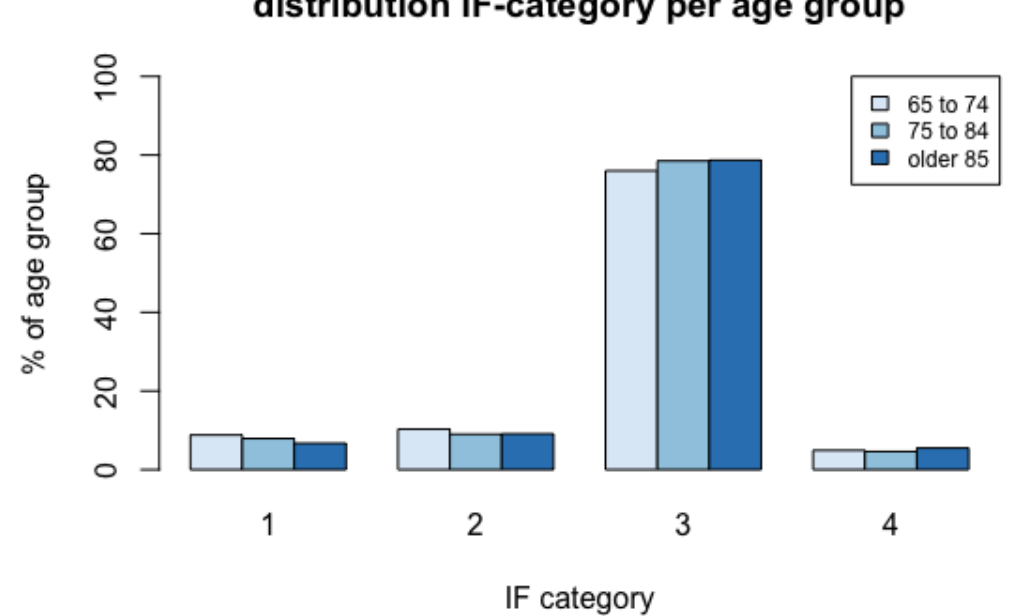
Figure 2. Distribution of incidental finding (IF) categories per body region investigated.